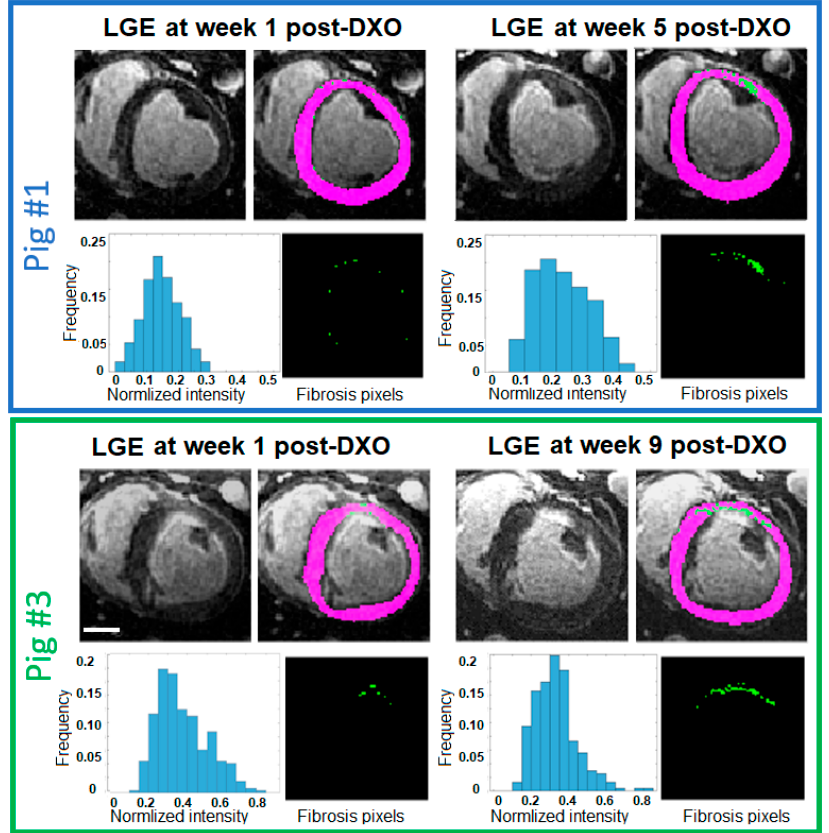
Figure 6. Representative results obtained by segmenting LGE images to distinguish fibrotic pixels (in green) from normal myocardium pixels (in magenta). For the green masks segmented in the MR slices presented, for pig #1, there are 11 fibrosis pixels out of 1003 total pixels of the LV at 1 week post-DOX, and 43 pixels out of 1092 pixels of LV at 5 weeks post-DOX. For pig #3, there are 11 pixels out of 905 LV pixels at 1-week post-DOX, and 65 pixels out of 939 LV pixels at week 9 post-DOX. White scalebar is 2